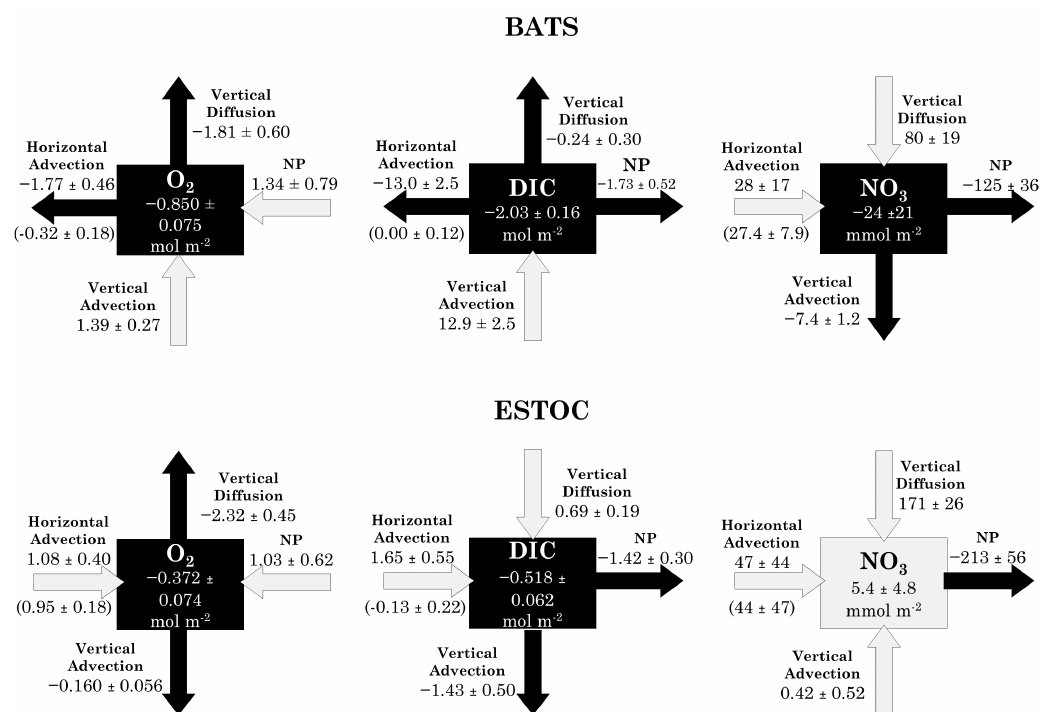
Fig. 8. Integrated model terms computed from the mixed layer depth to 110 m, and from April to December. NP is net production. Integrated geostrophic horizontal advection term is shown in brackets. The white (black) arrows and boxes represent net gain (lost). Rates are expresed in mol m − 2 for oxygen and DIC and in mmolm − 2 for